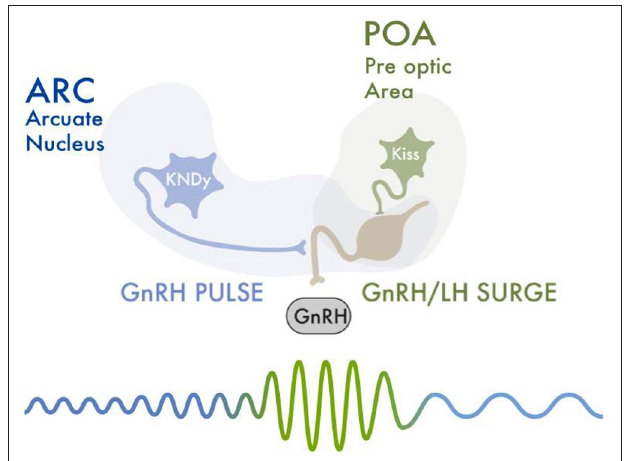
FIGURE 1 | An increase in FSH levels leads to recruitment and development of ovarian follicles. Selected follicles produce rising estradiol levels. Estradiol and inhibin exert a negative feedback upon the HPG axis, thus decreasing FSH levels. Estradiol also causes a negative feedback upon the Kiss ARC neurons. Kisspeptin-neurokinin B-dynorphin (KNDy) neurons present in the hypothalamus’s arcuate nucleus (ARC), co-express neurokinin B (NKB) and dynorphin (Dy) and are essential for GnRH pulse generation and secretion. Low frequency hypothalamic GnRH pulses lead to a release of FSH and LH from the anterior hypophysis. One of the selected ovarian follicles becomes dominant, and secretes increasingly high levels of estradiol. This rapid and sustained increase in estradiol values gives the required signal to activate the Kiss RP3V / POA neurons. This activation triggers the GnRH pulsatility and release, necessary for the LH/FSH surge. The LH surge is initiated, which causes follicular luteinization and an initial progesterone rise. Progesterone